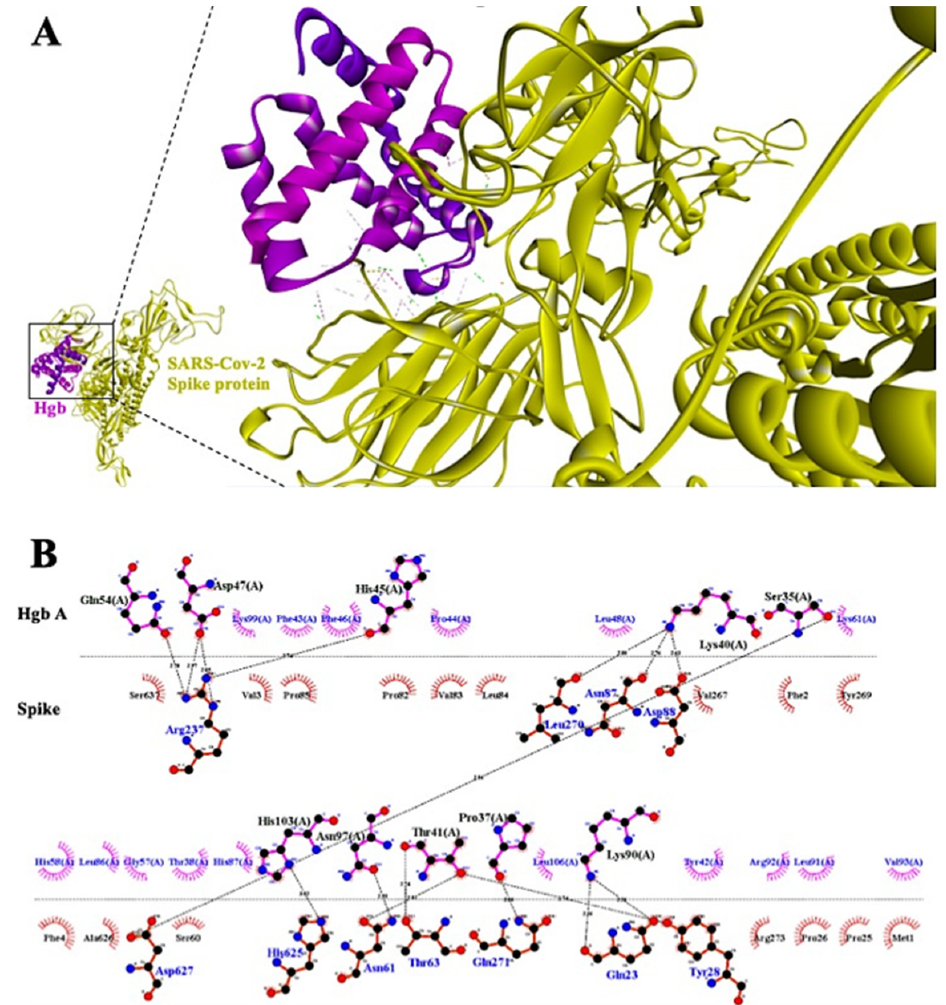
Figure 3. ( A ) Three-dimensional representation of the interaction between the Spike protein (in yellow color) and hemoglobin monomer (in magenta color) and detailed representation of the binding area. ( B ) Two-dimensional interaction plot was formed via LigPlot. Interaction may occur at S1-NTD with the referred amino acids from each side. In the green dashed line, hydrogen bonds are represented and radian arches represent weaker electrostatic bonds that participating in the